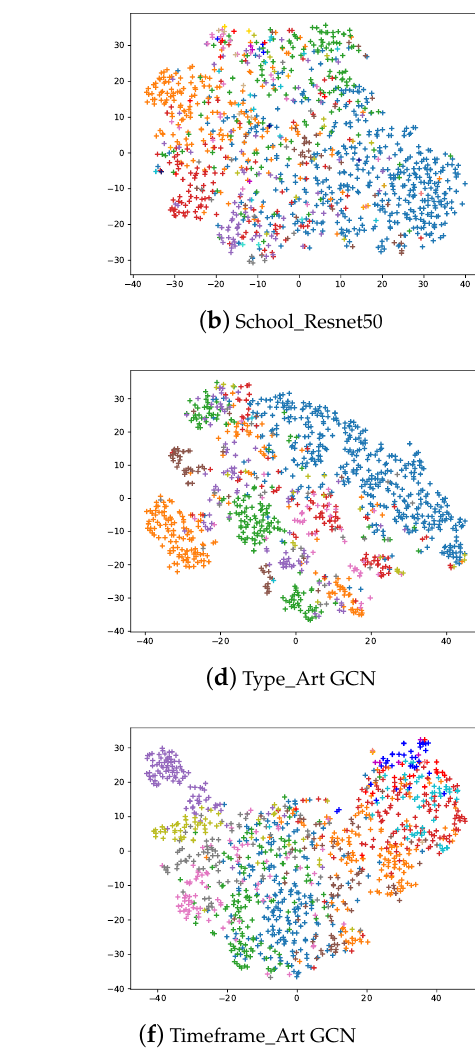
Figure 6. The t-SNE visualization of the image embedding and artistic comment embedding in the test